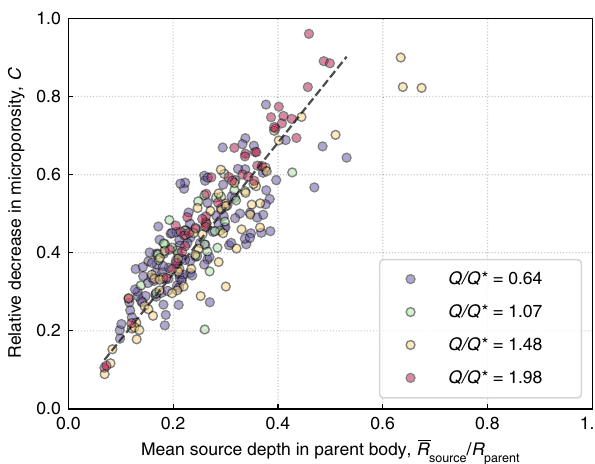
Fig. 7 Microporosity can be a predictor of the material provenance within the parent body. The mean compaction of the particles that make up an individual rubble-pile aggregate in our simulations is a measure of the microporosity of that aggregate. We show the mean compaction for all four cases described in Table 1. The color of each scatter point represents its associated simulation: purple, green, yellow, and red circles are aggregates from the Q / Q* = 0.64, 1.07, 1.48, and 1.98 cases, respectively. We fi nd that the change in a rubble pile ’ s microporosity relative to that of the parent body material ( y -axis) is an indicator of that material ’ s original location from within a parent body ( x- axis, parameterized by the mean source region of all particles making up the rubble pile, (cid:1) R , normalized by the source parent body radius, R ), regardless of the energy of the family forming parent impact. This is illustrated by the black dashed line, which is a linear fi t to = R data from all simulations, and has the form C = (1.68 ± 0.02) (cid:1) R source parent crucial clues regarding the in fl uence of the impact process on the observed diversity in hydration levels of carbonaceous asteroids and meteorites. Furthermore, the apparent presence of exogenous material contaminating Bennu and Ryugu, with different com- positions from one object to the other 41,42 , may also help in revealing the true relationship between the two objects.